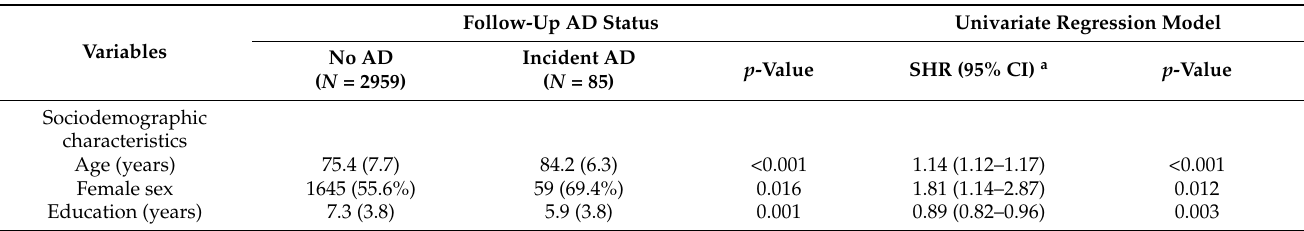
Table 1. Baseline characteristics according to incident AD status and associations between individual risk factors and AD risk. Follow-Up AD Status Univariate Regression Variables